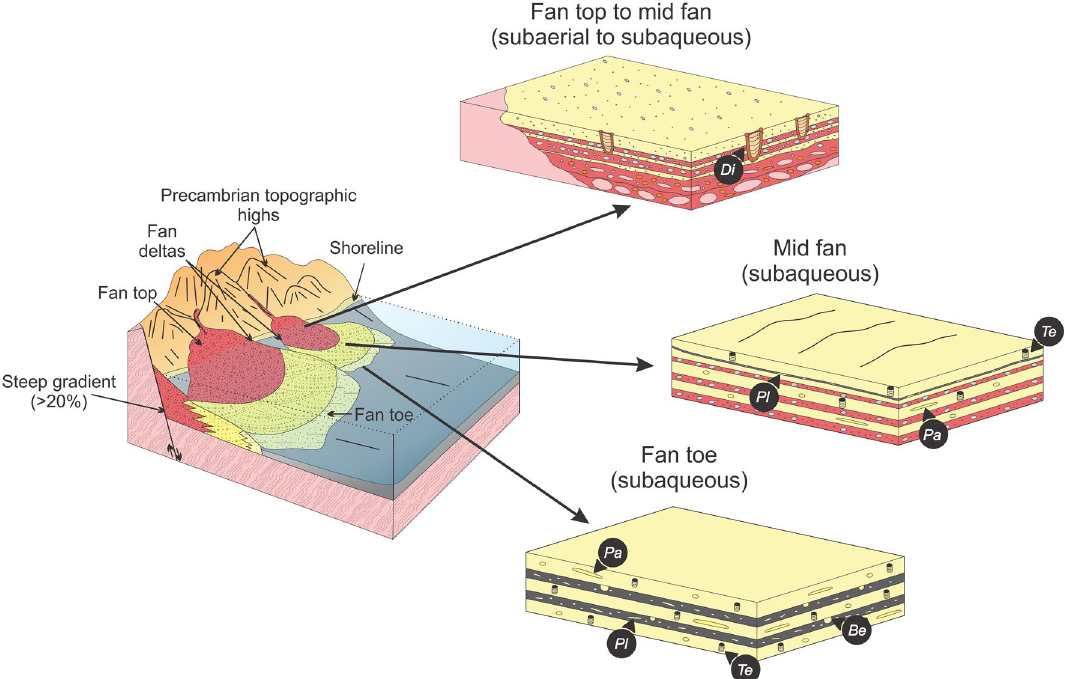
Figure 4. Block diagram showing trace-fossil distribution in Cambrian fan-delta subenvironments. Block diagrams drawn by A.I. using CorelDRAW 2017 v.19.1.0.419